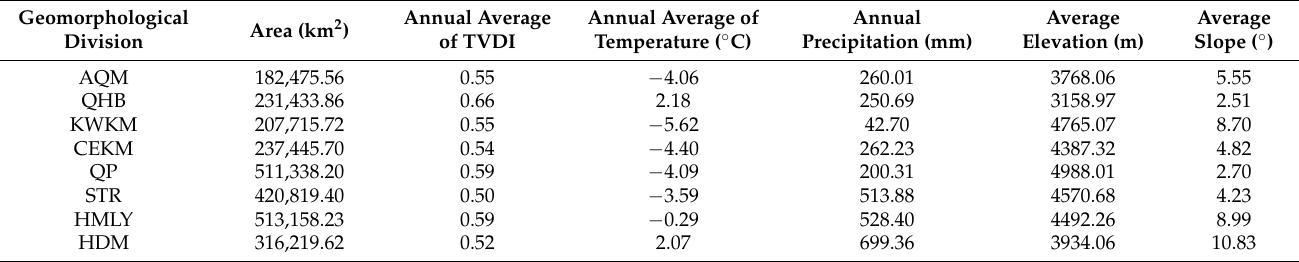
Table A2. Basic information of each geomorphological